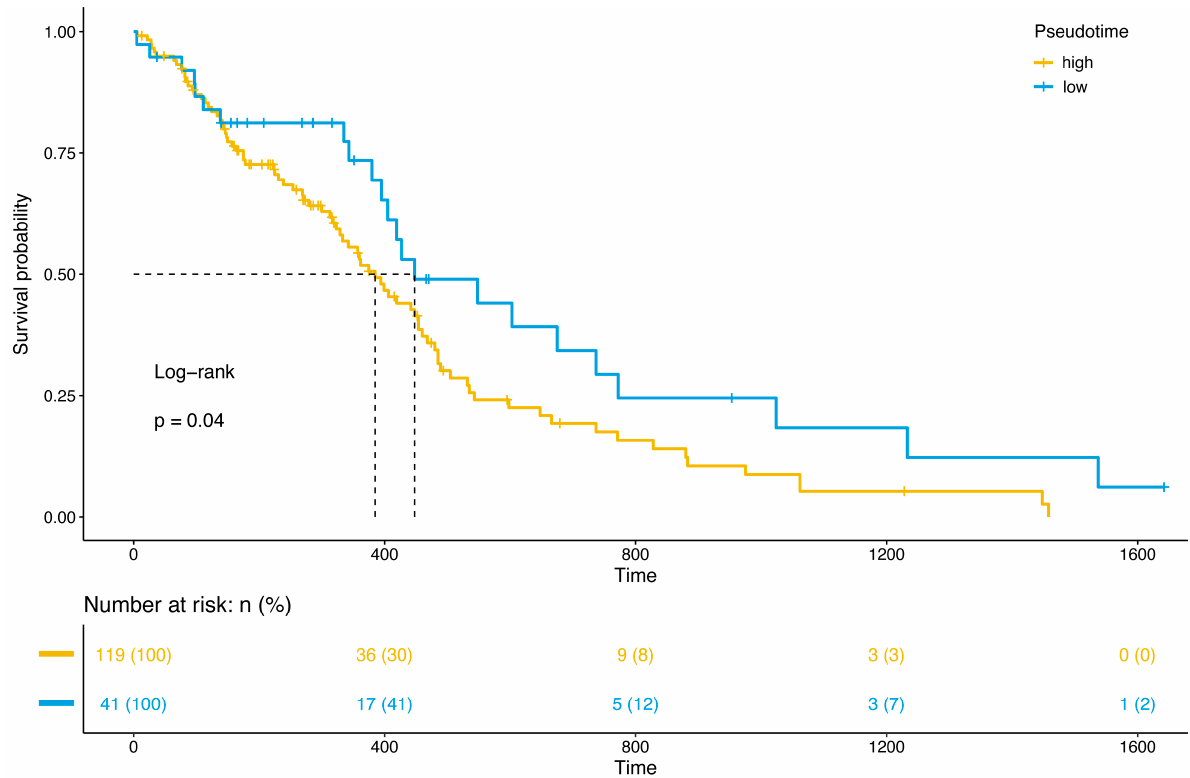
Figure 7. Prognosis analysis of pseudotime. The X-axis is time (days), and the Y-axis is survival rate. Patients are divided into high and low groups based on the pseudotime values. Survival curves are drawn, and a log-rank statistical test is performed.